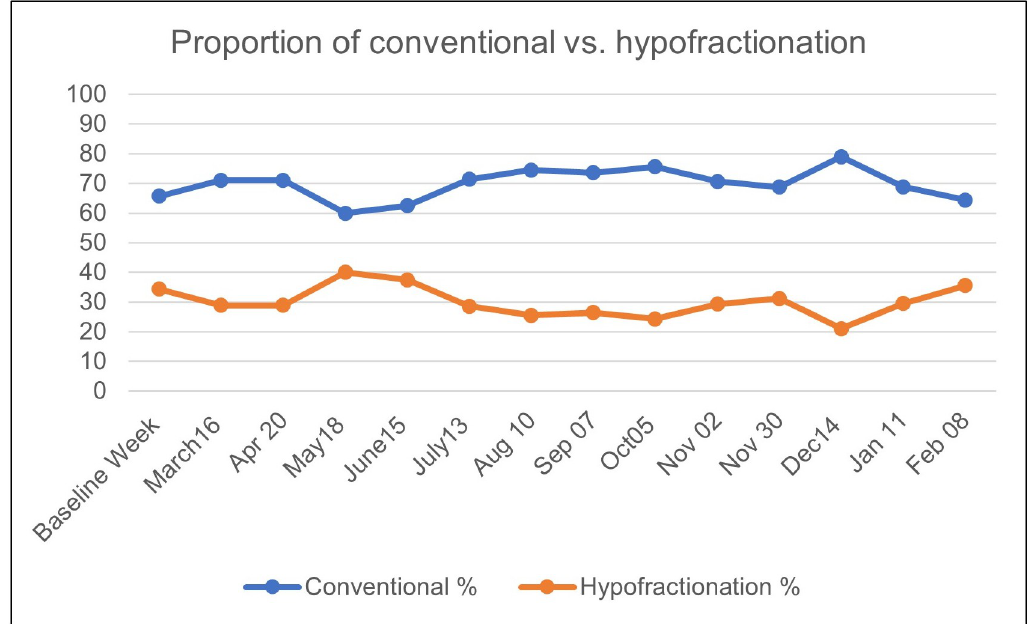
Fig 5. Changes in fractionation. Proportion of conventional fractionation versus hypofractionation (%) in the baseline week and throughout the pandemic.